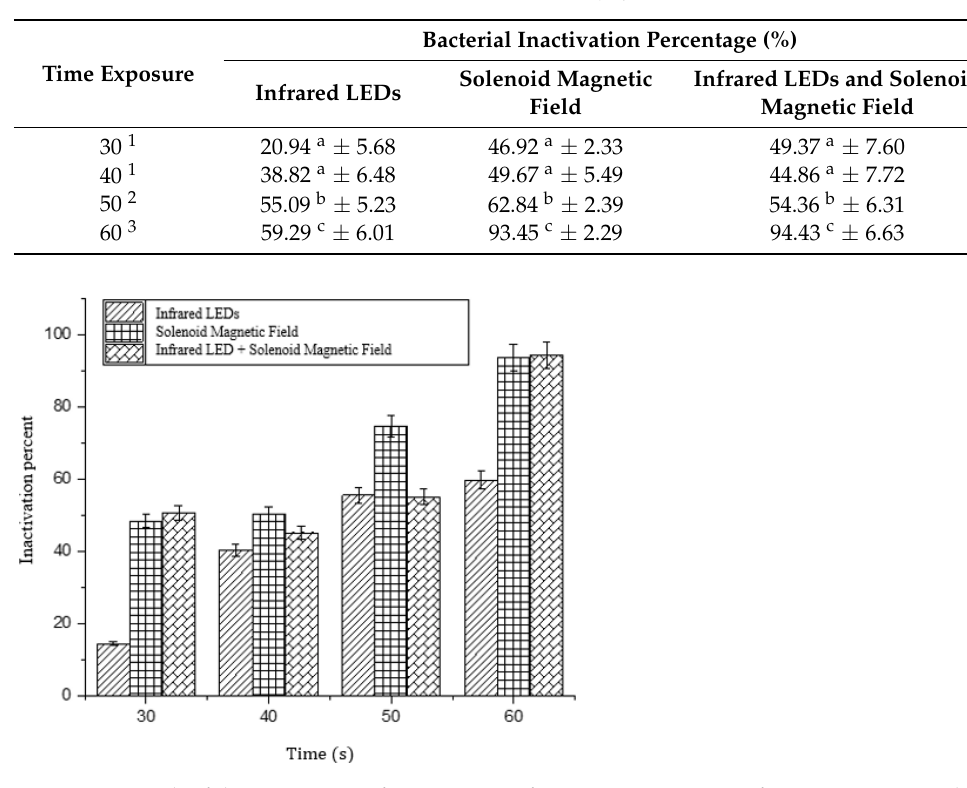
Table 4. Table of conclusions of statistical test results on Staphylococcus aureus .